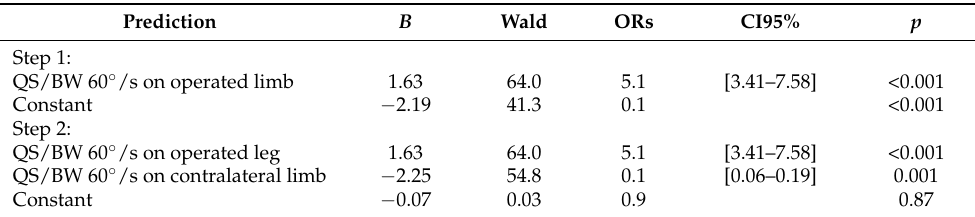
Table 5. Models of prediction of a return to running, analyzing legs (operated/contralateral) as a unit (peak torque to body